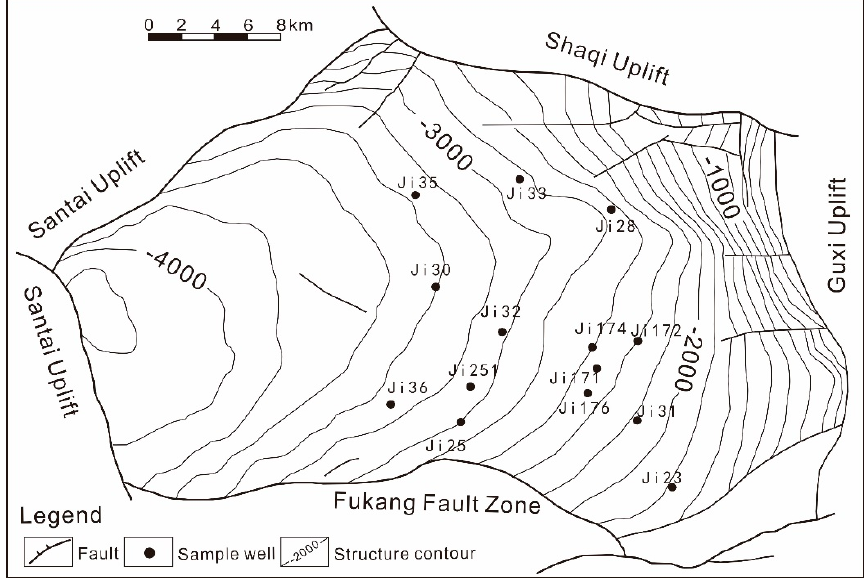
Figure 1. Depth contour in meters of the top of Lucaogou Formation and location of wells.